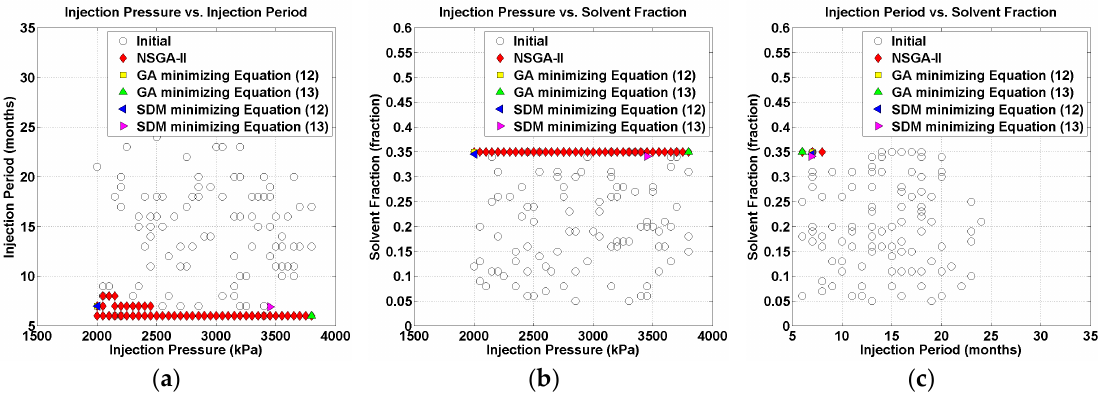
Figure 9. Projection of decision variables in two-dimensional variable space before and after optimization. The evolved solution set obtained from multi-objective optimization includes the optimum solution obtained from global-objective optimization: ( a ) P inj vs. T inj ; ( b ) P inj vs. S frac ; and ( c ) T inj vs. S frac .